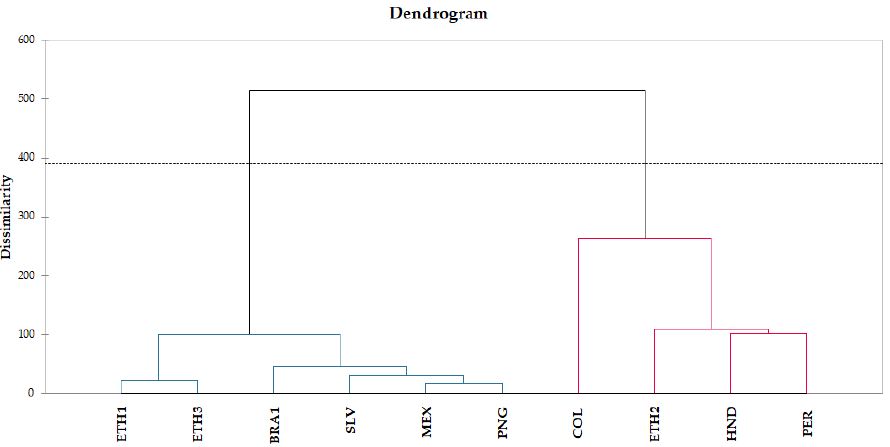
Figure 4. Hierarchical cluster analysis (HCA) of coffee samples.